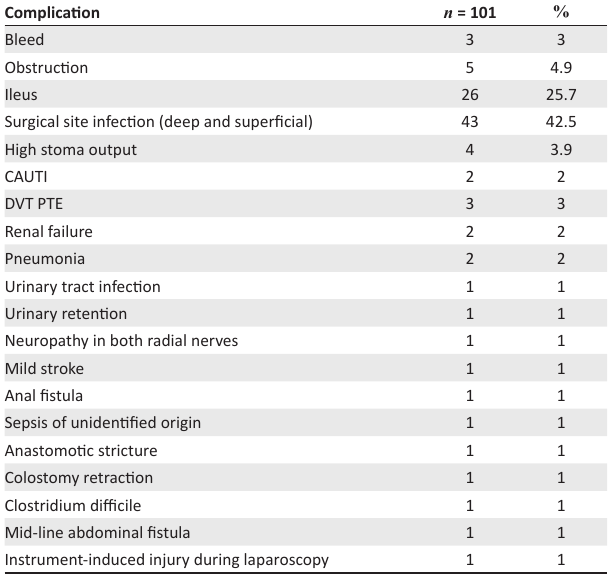
TABLE 4: Frequency of postoperative complications ( n = 125).